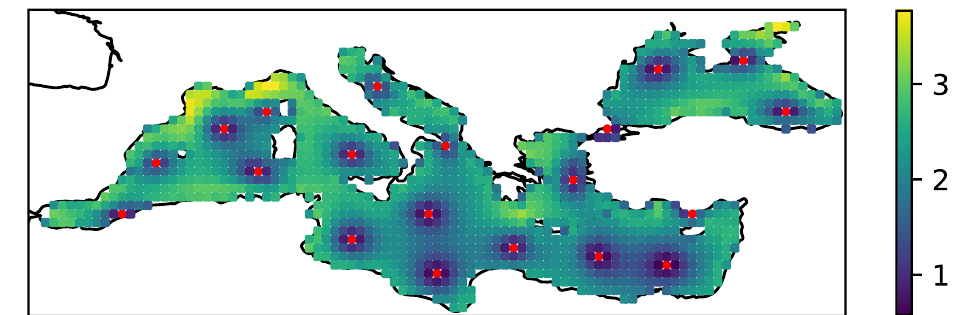
Figure 6. Spatial distribution of amplitude error ( A ) for the selection of 20 sensor location. The red dots denote the optimal sensor location selected by the algorithm that does not take into account the distance to